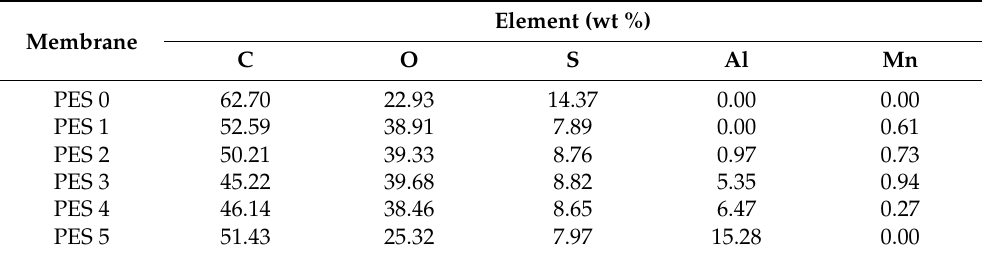
Table 1. EDX analysis for PES 0 to PES